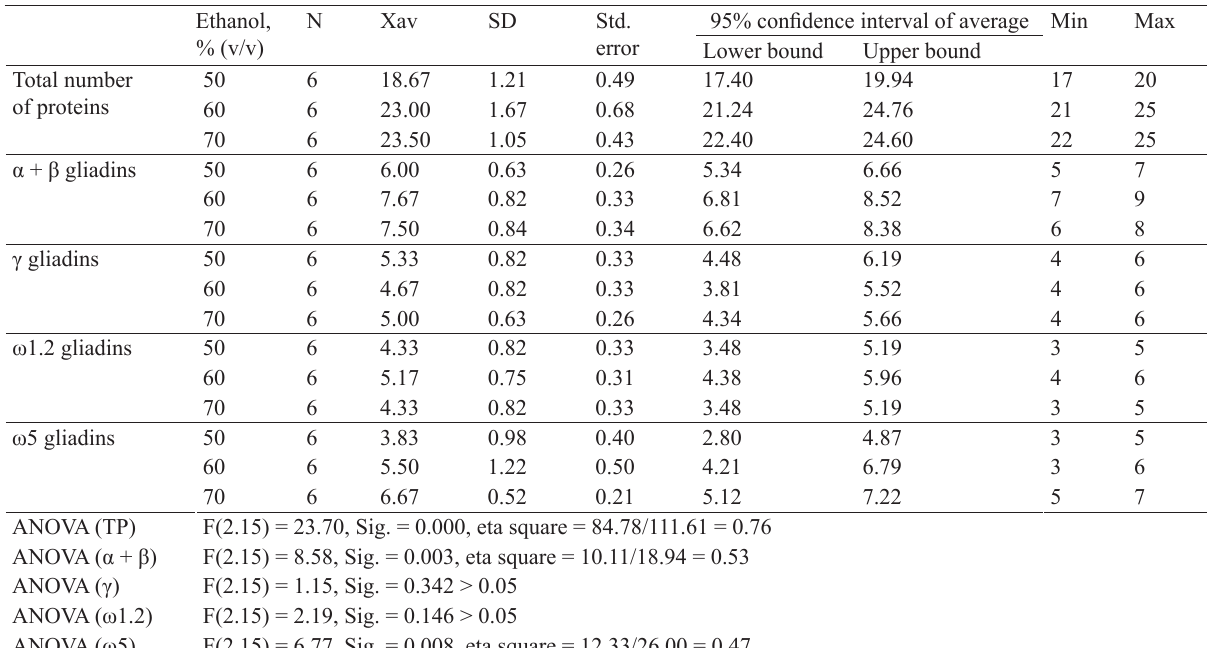
Table 2 Descriptive indicators of total proteins and gliadin proteins separated by fractions (Agilent, CE 7100, capillary inside diameter 50 µm, total capillary length 33 cm, effective capillary length 23.50 cm, capillary temperature 25°C, voltage –16.5 kV (reverse mode), duration 30 min, absorbance measured at 220 nm)